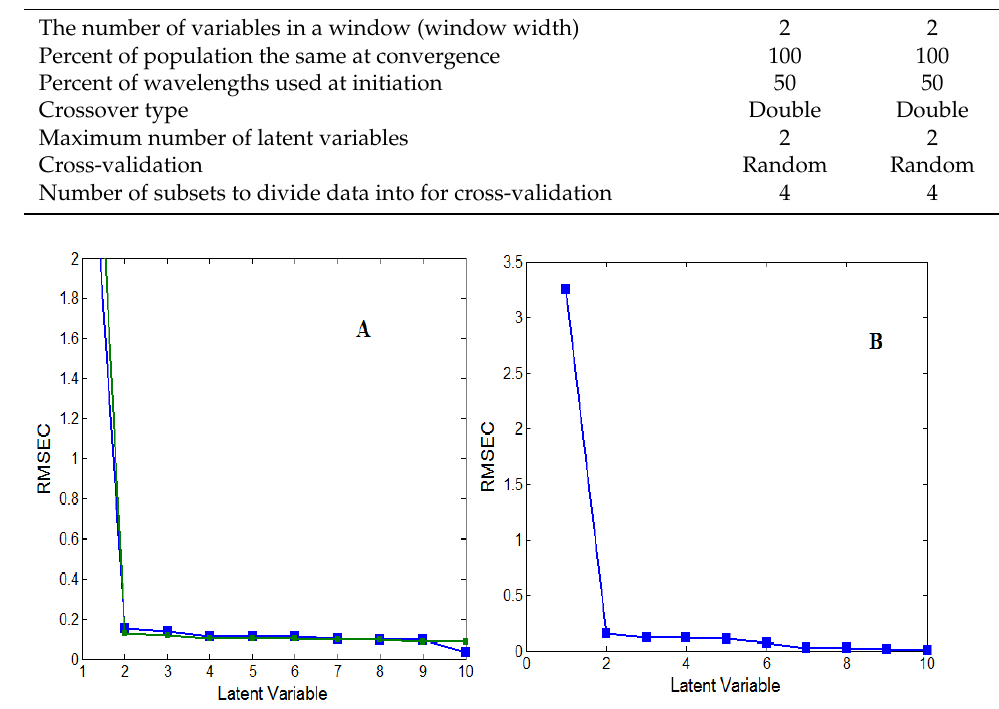
Figure 3. Cross-validation plot of the ( A ) PCR and ( B ) PLS-1 models for FAV and MLP. Table 2. Parameters of the developed GA – PLS-1 model.